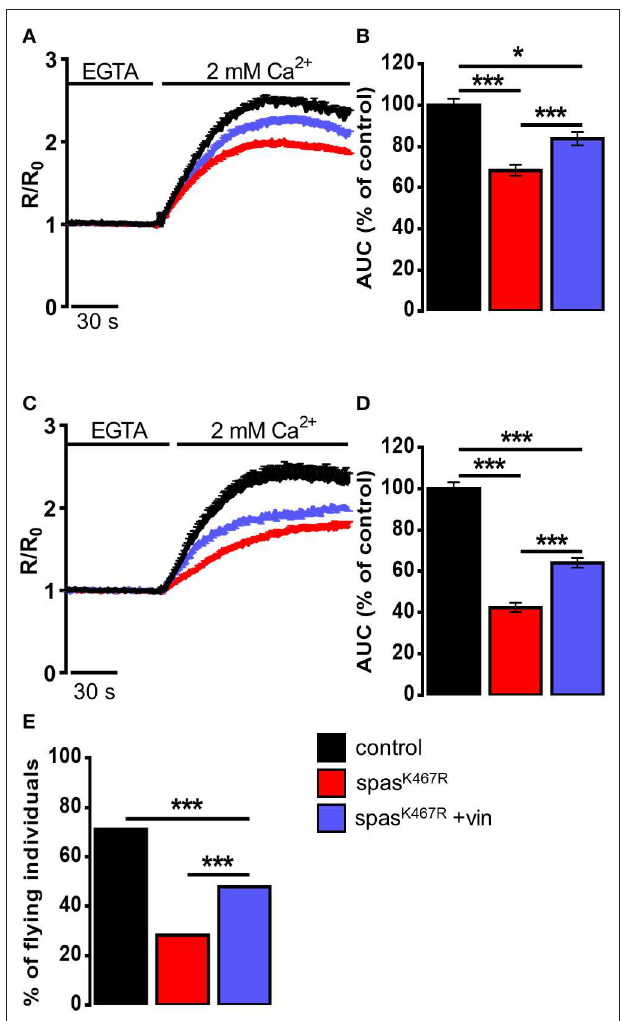
FIGURE 4 | (A–D) Ca 2 + dynamics induced by SOCE activation in neurons dissociated from larval brains expressing spastin K467R , and relative control, as detected by fura-2. Were indicated, vinblastine was applied: (A,B) during development, larvae were chronically treated with 50nM vinblastine or (C,D) after dissociation, neurons were acutely treated with 1 µ M vinblastine. Cells were pre-treated with thapsigargin for 8min to empty intracellular stores, then 2mM CaCl 2 was added. Traces are presented as average R/R 0 values of n > 100 cells. (B,D) Histograms reporting the average area under curve (AUC) values of the corresponding traces. Data are presented as mean ± SEM of n > 100 cells. * p < 0.05; *** p < 0.001. (E) Flight ability, assayed by the cylinder drop test, of animals expressing spastin K467R and relative control. Where indicated, animals were chronically exposed to vinblastine (50nM). Data are presented as the percentage of flying individuals. Mean of n > 100 cells. *** p <